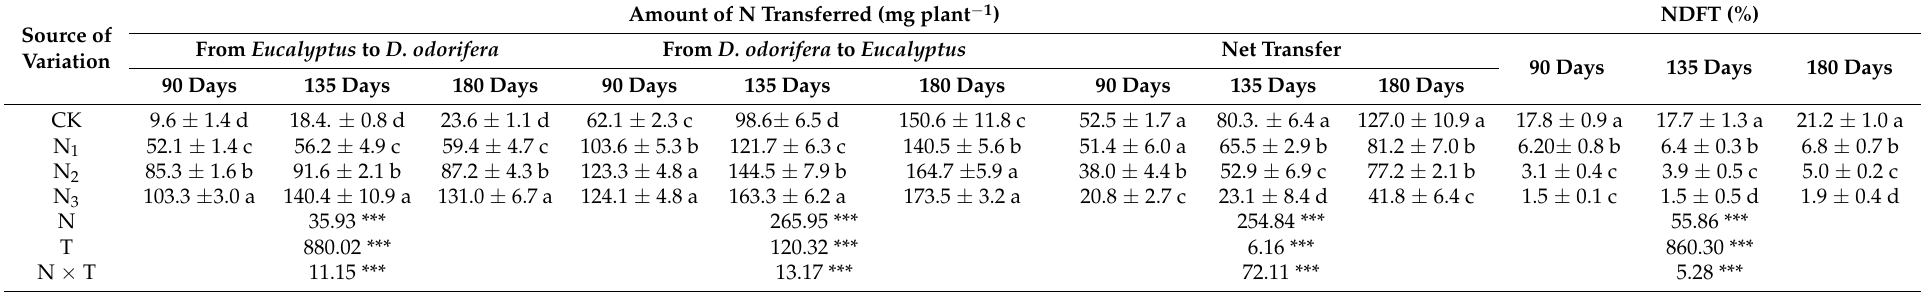
Table 2. The mean values of the net amount of N transferred and the percentage of TN content (NDFT (%)) in Eucalyptus plants as a result of N level, time, and their interaction. Source of Variation